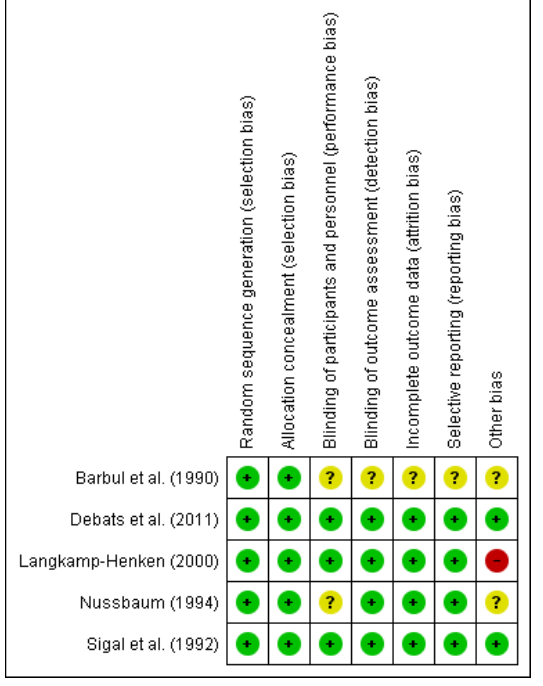
Figure 6. Risk of bias summary for the included studies on arginine. Low risk of bias (+), unclear risk of bias (?), and high risk of bias (−).